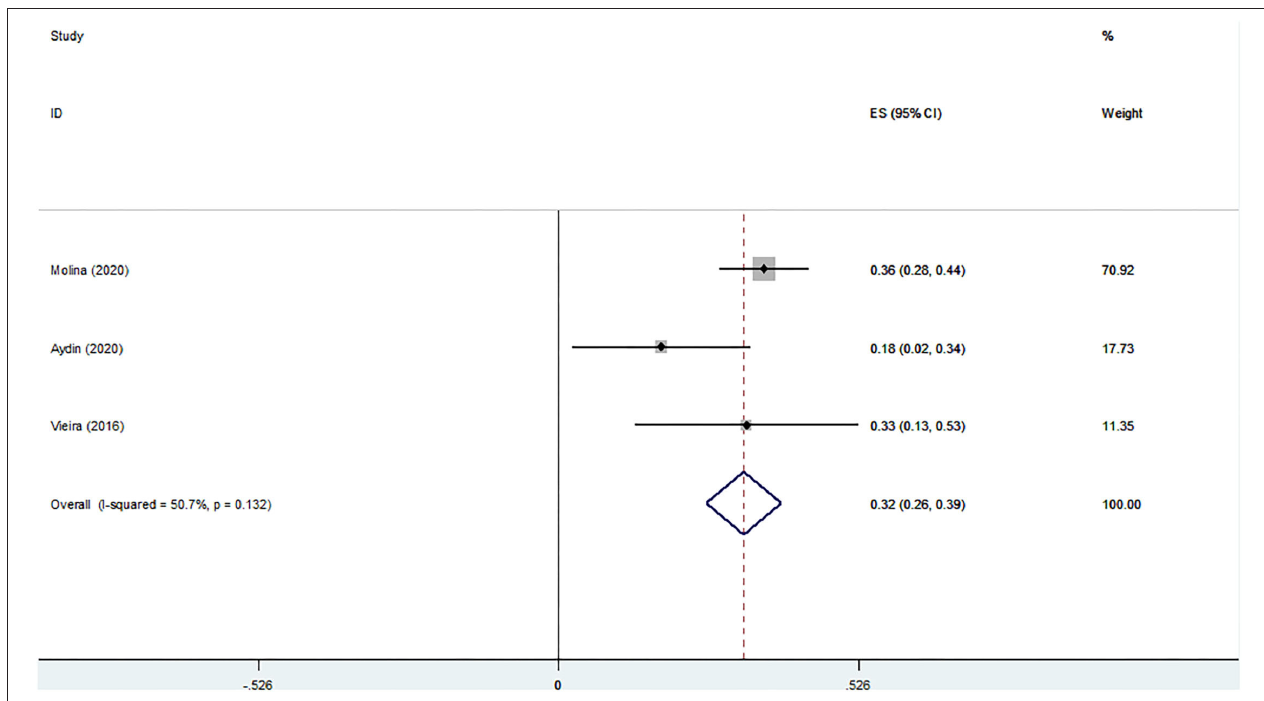
FIGURE 7 | Z-scores for meaning in